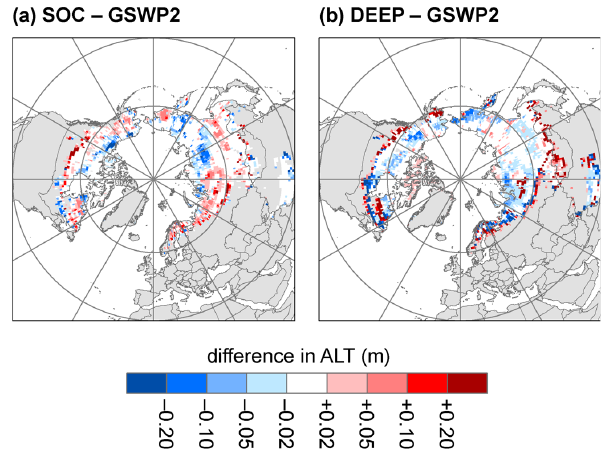
Fig. 5. Difference in mean ALT over 1983–1995 between the GSWP2 run (standard JULES) (cf. Fig. 1) and (a) SOC (JULES with soil parameters modified according to organic content); and (b) DEEP (JULES with soil profile extended to 60m depth). Note positive values (red colours) signify the mean ALT is deeper in the modified setups than in GSWP2, negative values (blue) means it is